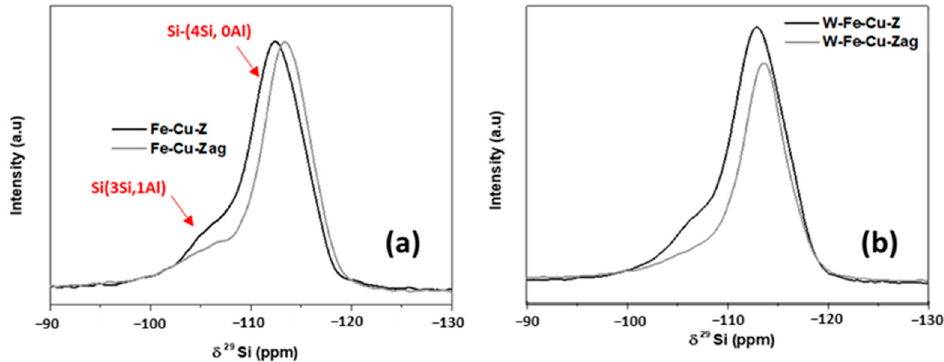
Figure 5. 29 Si NMR spectra of fresh and aged ( a ) Fe-Cu-Z and ( b ) W-Fe-Cu-Z.